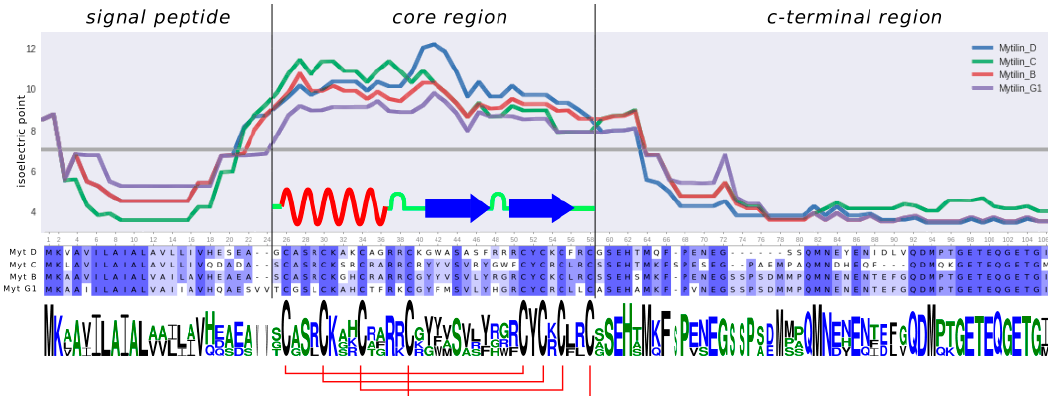
Figure 1. Secondary structure, isoelectric point distribution, sequence conservation logo and disulfide bridge array for mytilin B, C, D and G1 of Mytilus galloprovincialis . The isoelectric point plot was generated with a sliding window size of 15 amino acids. The secondary structure of the mature peptide region reports experimental data obtained for mytilin B (PDB: 2EEM).